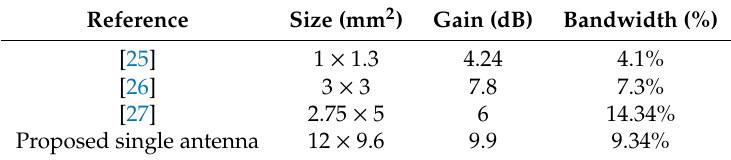
Table 5. Comparison between previously published work and the proposed single patch antenna.